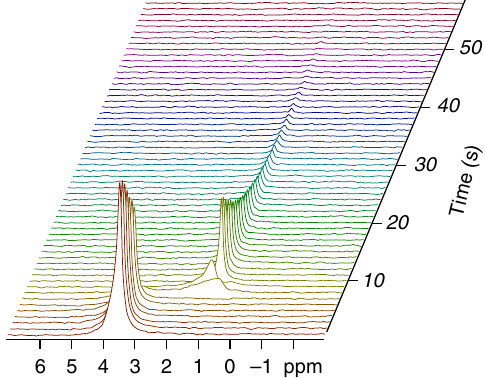
Fig. 3 31 P NMR spectra of hyperpolarized Pi at two different pH values. These spectra demonstrate the ability for fast monitoring of pH changes with hyperpolarized Pi. The repetition time in this experiment was 1 s and the nutation angle was 10°. The initial pH was determined in a separate measurement to be 8.1. At about 9 s, 0.5 ml of citrate-Tris buffer in pH of 4.5 was mixed into the solution. The fi nal pH was determined in the same sample to be 4.8. The wide signals in spectra 8 and 9 are due to the mixing process, which involved air bubbles going through the sample during the measurement. The line widths of the hyperpolarized signals were 9 and 7 Hz at pH 8.1 and 4.8, respectively